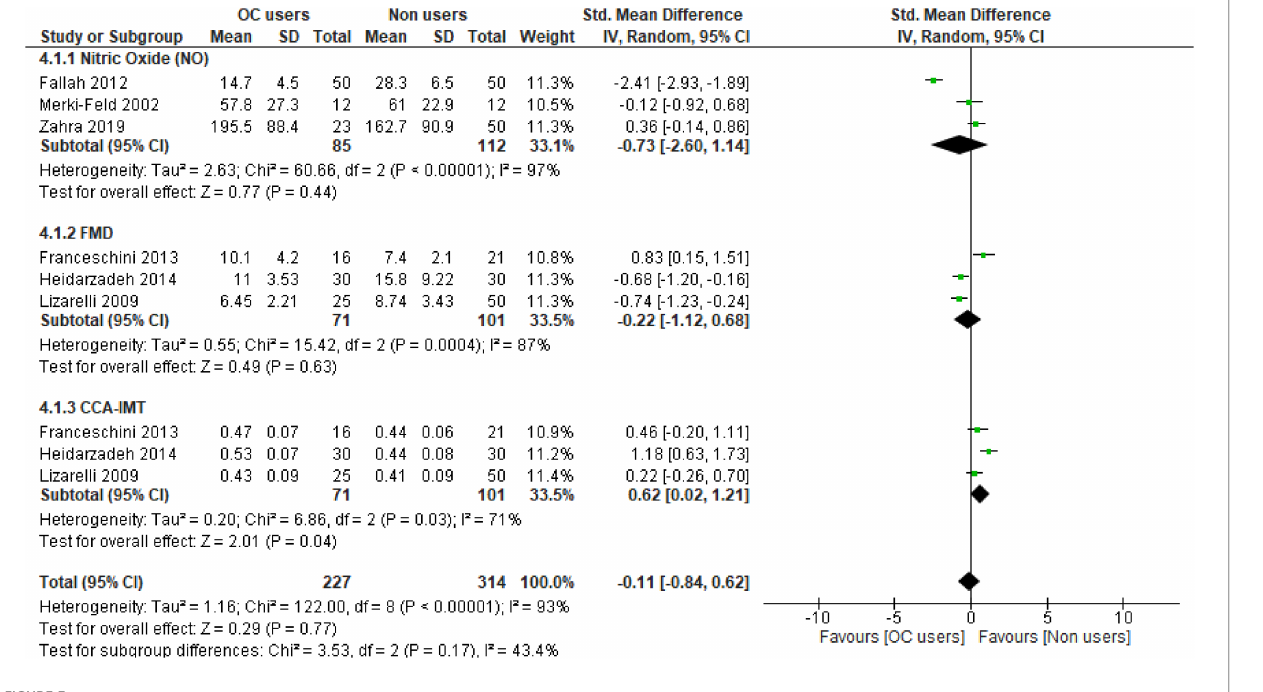
FIGURE 3 Forest plot of cellular and vascular markers of endothelial activation in premenopausal women on OCs vs. non-OC